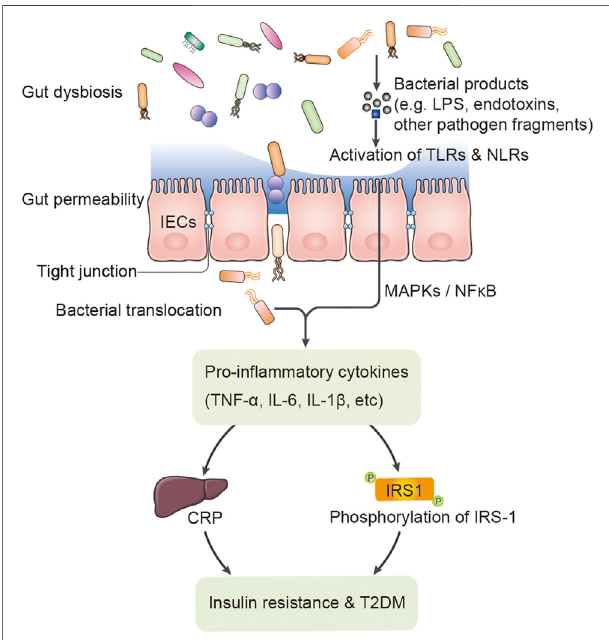
FIGURE 1 | The putative relationship between gut dysbiosis and